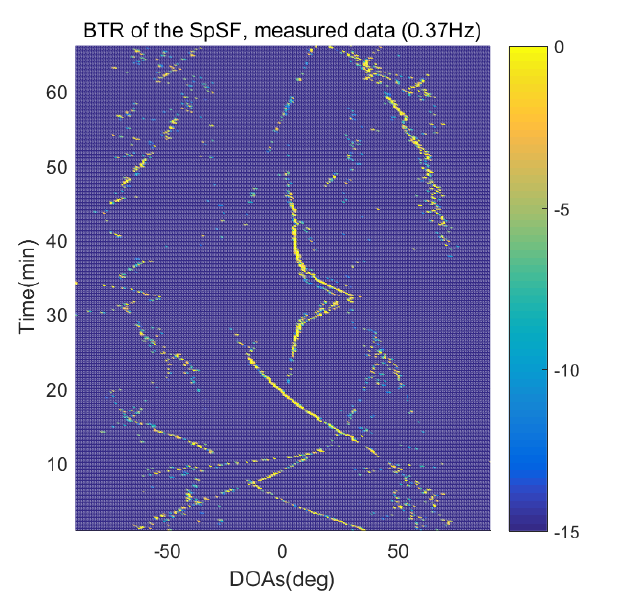
Figure 20. Bearing time records of the SpSF: 66 min, signal frequency = 0.37 Hz.